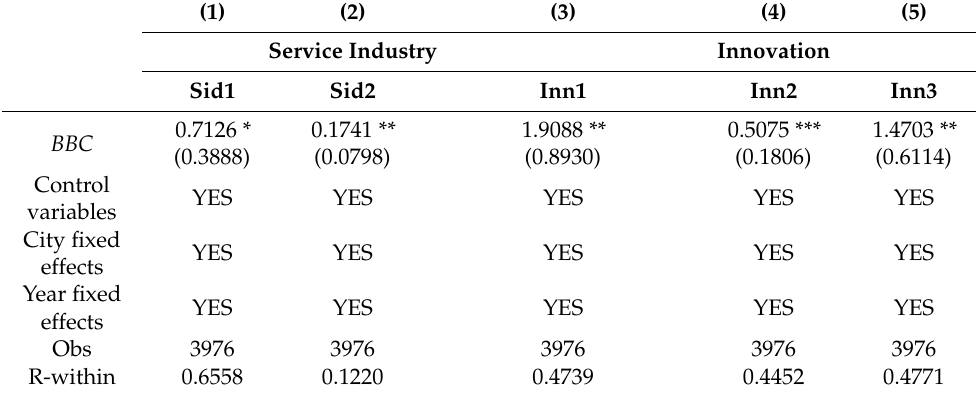
Table 6. Information infrastructure and service industry and